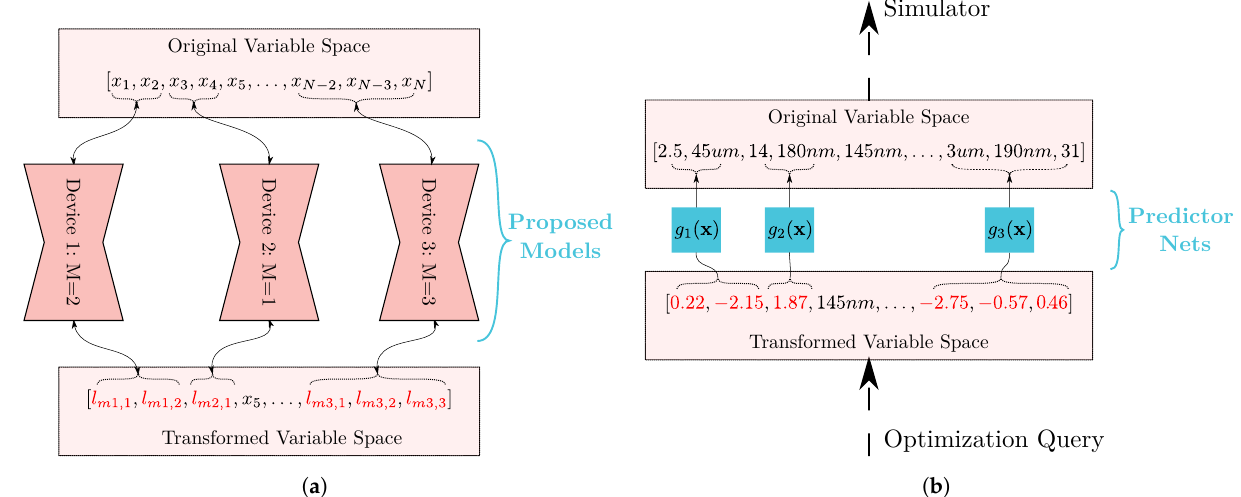
Figure 3. The proposed device representation learning scheme within a sizing problem, where the latent variables are shown in red. ( a ) The original variable space of the sizing problem is changed into a transformed one, by mapping sets of variables that belong to devices into continuous latent ones. ( b ) During the optimization, a query from the optimization algorithm is transformed back to the original variable space using the predictor networks, prior to